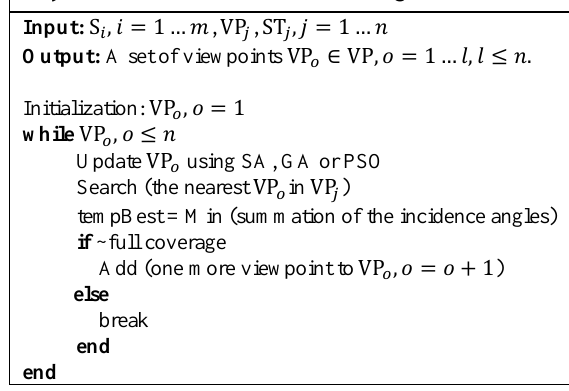
Table 3. Algorithm